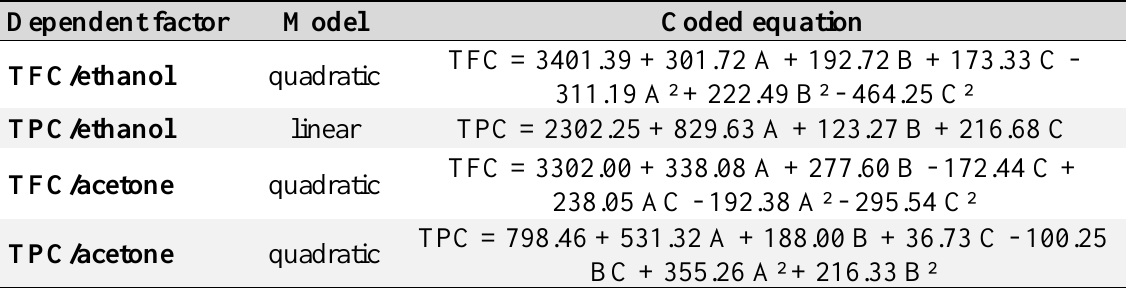
Table 5. Model and coded